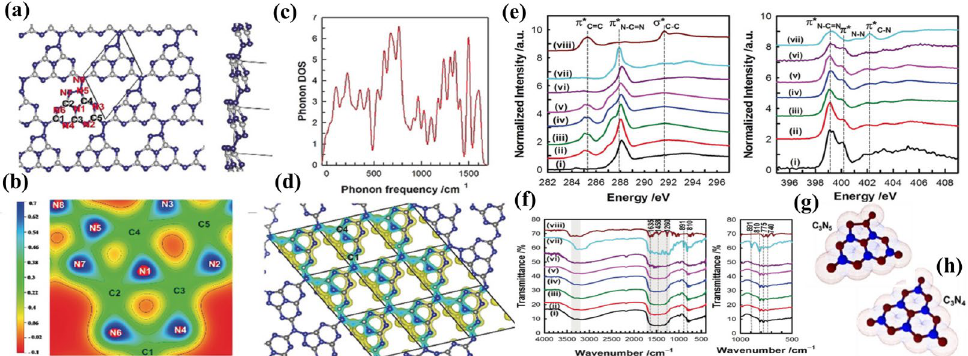
Figure 2. Theoretical and experimental results of g-C 3 N 5 containing one-triazole and two-triazine: ( a ) Optimized geometric structure (gray for C atoms and blue for N atoms); ( b ) 2D charge density distribution; ( c ) Phonon DOS; ( d ) 3D charge density (yellow regions: electron-rich areas, cyan regions: electron-deficient areas); ( e ) Carbon K-edge (left) and nitrogen K-edge (right) NEXAFS spectra (the black line indicates MCN-11); ( f ) FT-IR spectra (the black line indicates MCN-11); ( g ) g-C 3 N 5 containing 1-NH 2 /NH-1,2,4-triazole units; ( h ) g-C 3 N 4 containing 2-NH 2 /NH-1,3,5-triazine units. ( a–f ) Adapted with permission from [21]. Copyright Wiley-VCH Verlag GmbH and Co. KGaA, Weinheim, 2018. ( g–h ) Adapted with permission from [26]. Copyright WileyVCH GmbH, 2020.